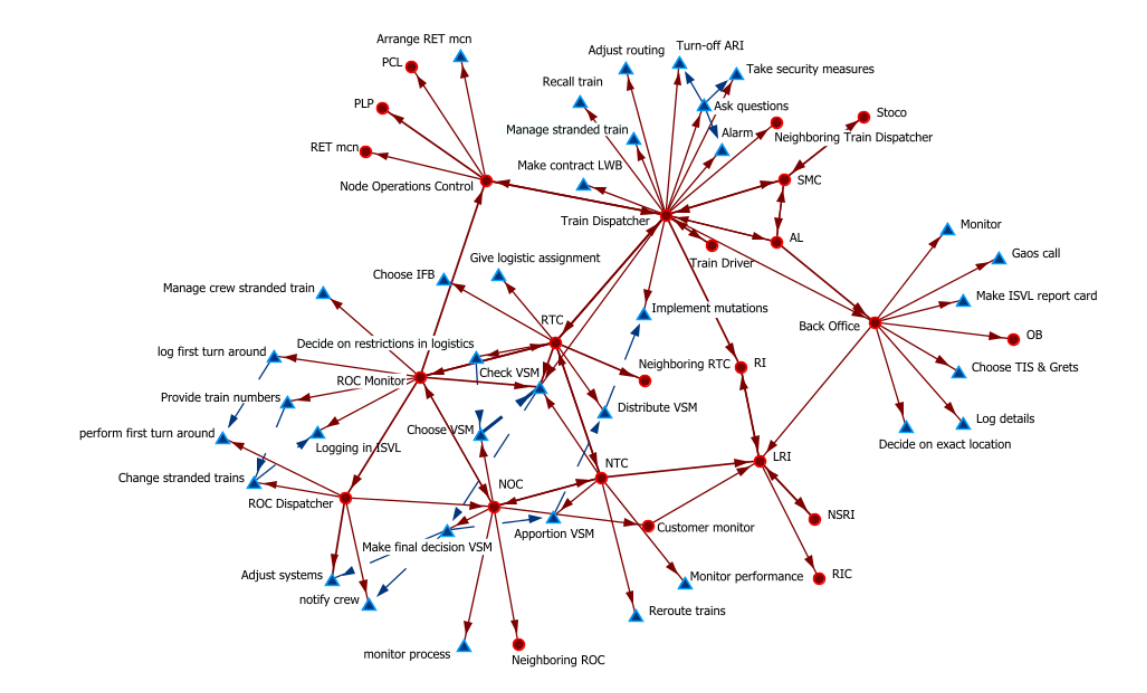
Figure 2. Overview of the overall network of actors and tasks during the management of damaged